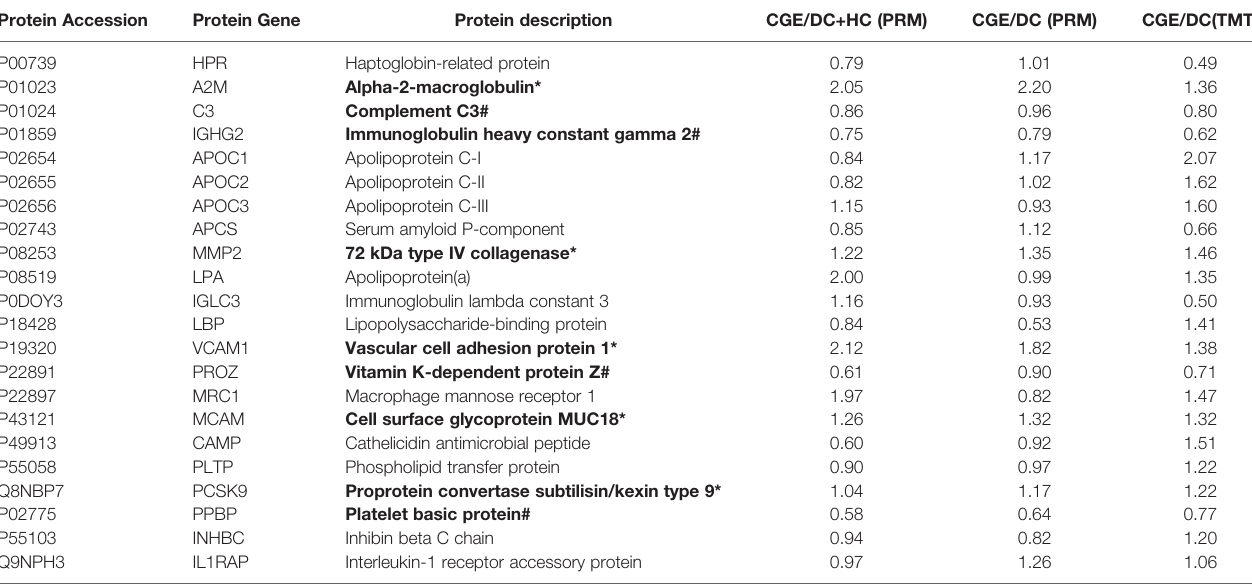
TABLE 2 | Validation of biomarker candidates by PRM